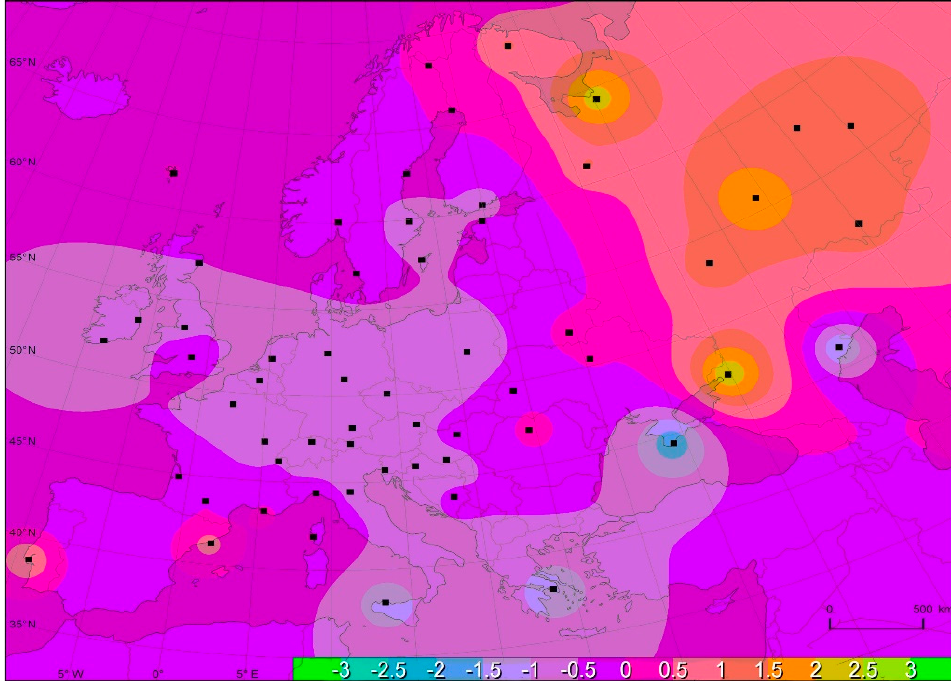
Figure 5. Isolines map of a phase of the periodic “signal” of T = 7 years. Weighting by amplitude is applied. The smoothing parameter is d = 100 km. The colouring is cyclic, which is not essential here as the prevailing phase is far from −π and π .